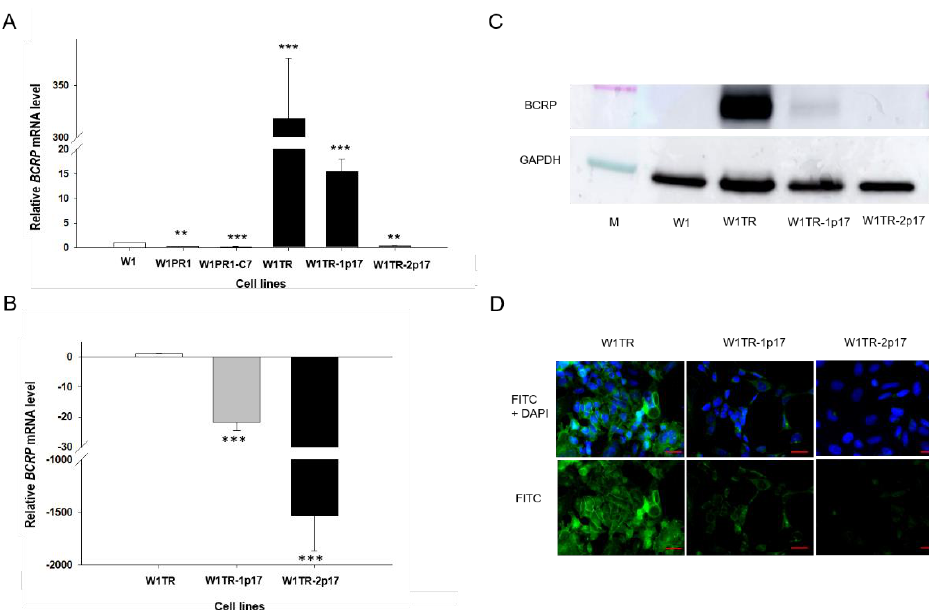
Figure 4. ( A ) Q-PCR analysis of BCRP transcript expression in the W1 cell line (white bar), W1PR1 and W1PR1-C7 cell line (gray bars), W1TR cell line, W1TR-1p17 and W1TR-2p17 cell lines (black bars). The figure presents the relative gene expression in the resistant cell lines with respect to that in the sensitive cell line, which has been assigned a value of 1; ( B ) Q-PCR analysis of BCRP transcript expression in the W1TR, W1TR-1p17 and W1TR-2p17 cell lines. The figure presents the relative gene expression in the CRISPR-Cas9-edited W1TR-1p17 resistant to TOP (topotecan) cell line (gray bar) and ALDH1A1+ W1TR-2p17 cell line (black bar) with respect to that in the resistant to TOP W1TR cell line, which has been assigned a value of 1 (white bar). The values were considered significant at ** p < 0.01 and *** p < 0.001. ( C ) Western blot analysis of BCRP protein expression in the W1, W1TR, W1TR-1p17 and W1TR-2p17 cell lines. A primary anti-GAPDH Ab served as a loading control for the cell lysates; M-protein molecular weight marker. ( D ) Immunofluorescence visualization of BCRP expression in W1TR, W1TR-1p17 and W1TR-2p17 cell lines. BCRP was detected using the anti-BCRP Ab and an Alexa Fluor ® 488-conjugated secondary Ab (green). DAPI was used to counterstain nuclei (blue). Objective 40×. Scale bar = 20 µm.